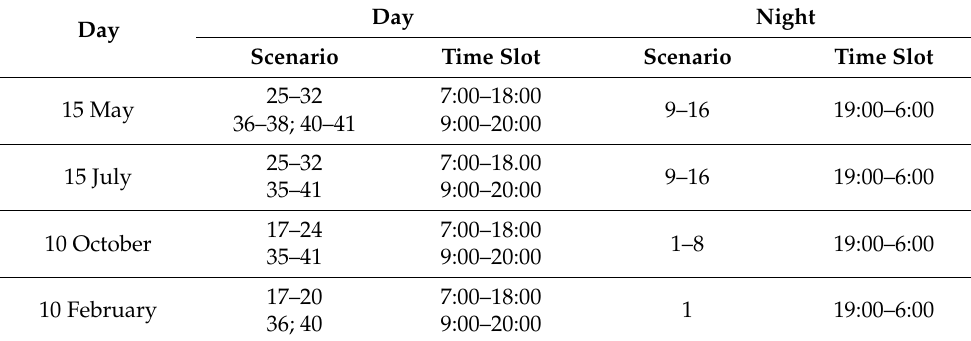
Table 4. Summary of daily calculation